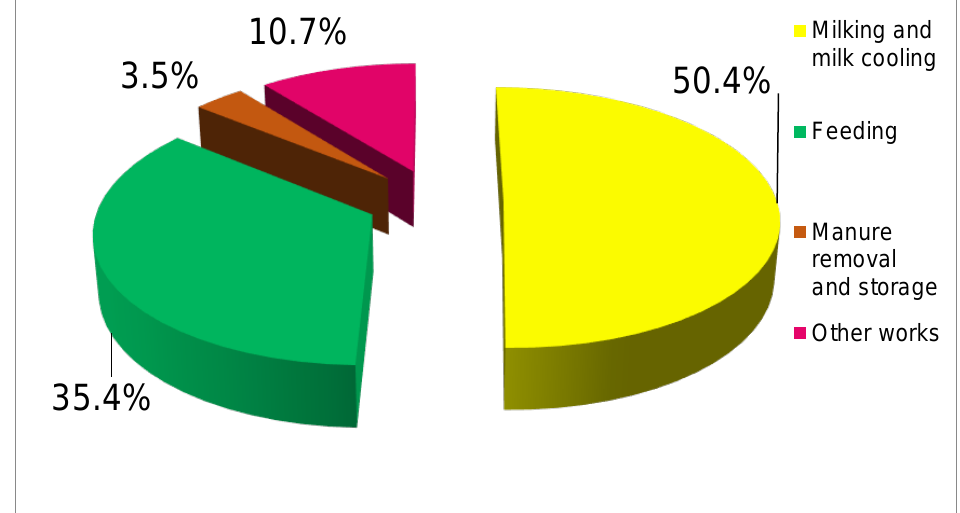
Labor inputs in the proposed module cattle barn are shown Figure 3.